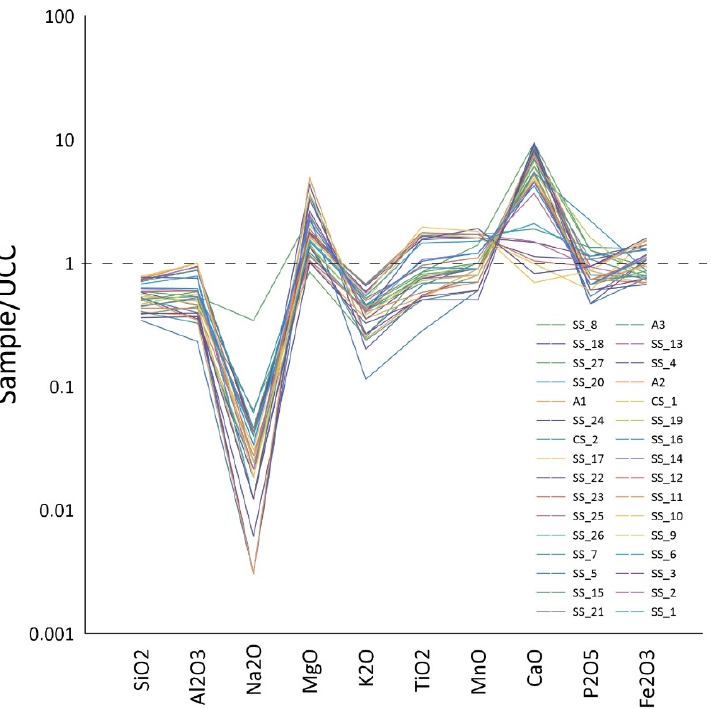
Figure 4. Upper ‐ Continental Crust (UCC) normalized major oxide diagram for the studied sam ‐ Figure 4. Upper-Continental Crust (UCC) normalized major oxide diagram for the studied ples.